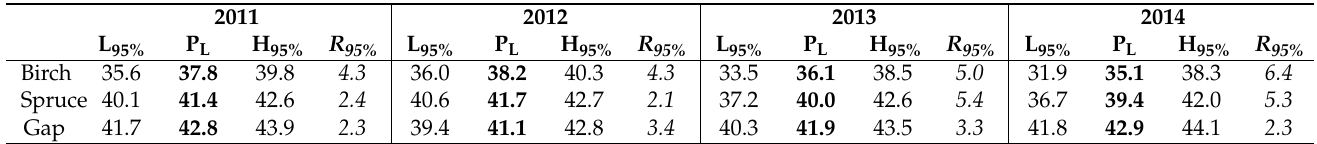
Table 3. The average volumetric topsoil water content (%) in the studied periods. P L —the average of daily pivot halfsums; L 95% , H 95% , and R 95% —the mean of daily pivot statistics representing a 95% confidence interval of the mean (lower limit, upper limit of the confidence interval, and their difference (range), respectively).